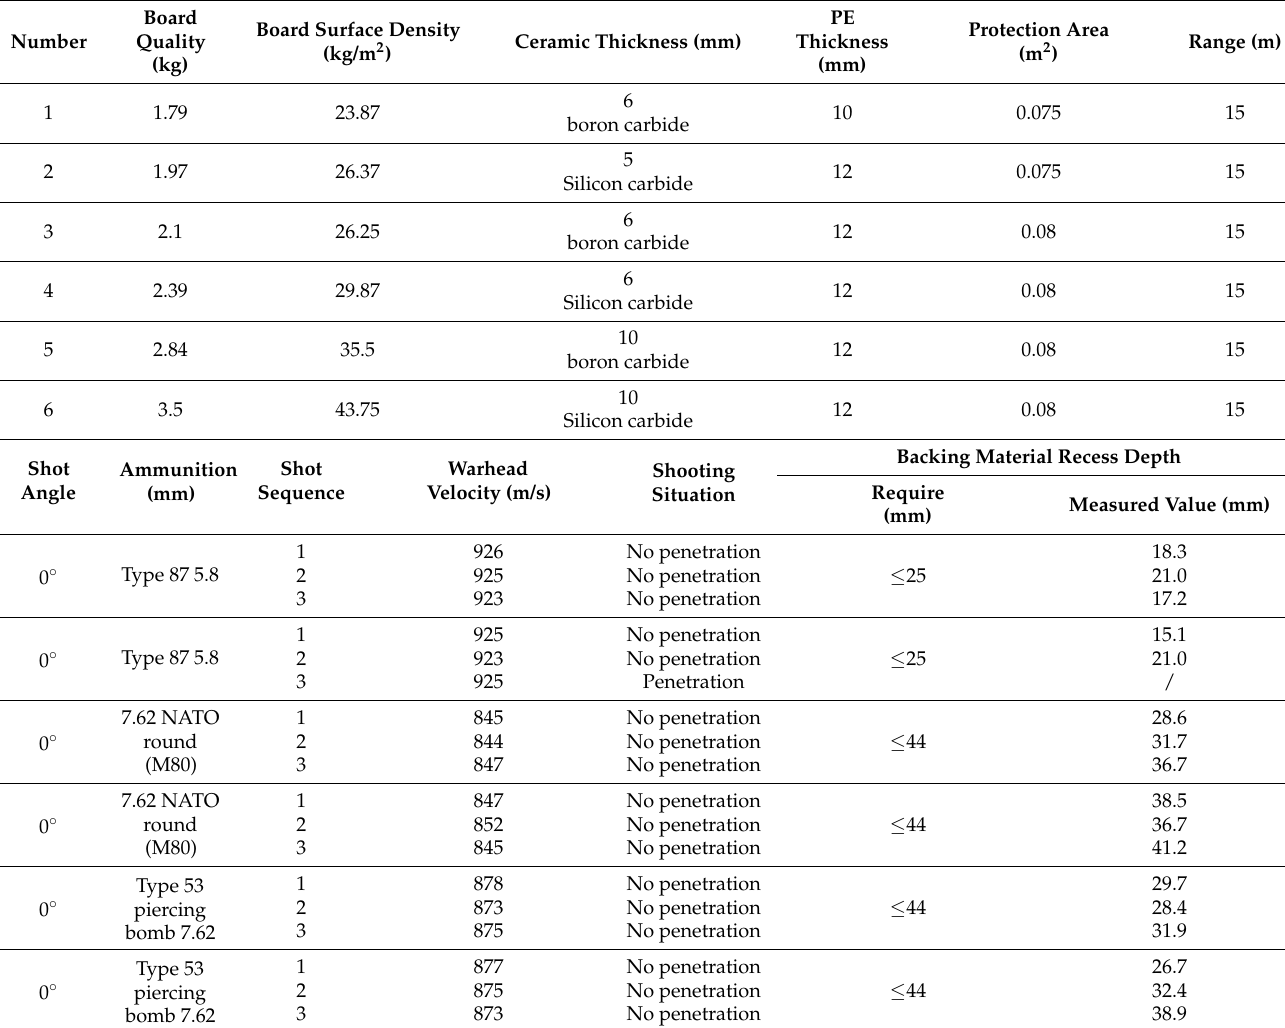
Table 3. Material parameters of the rotating